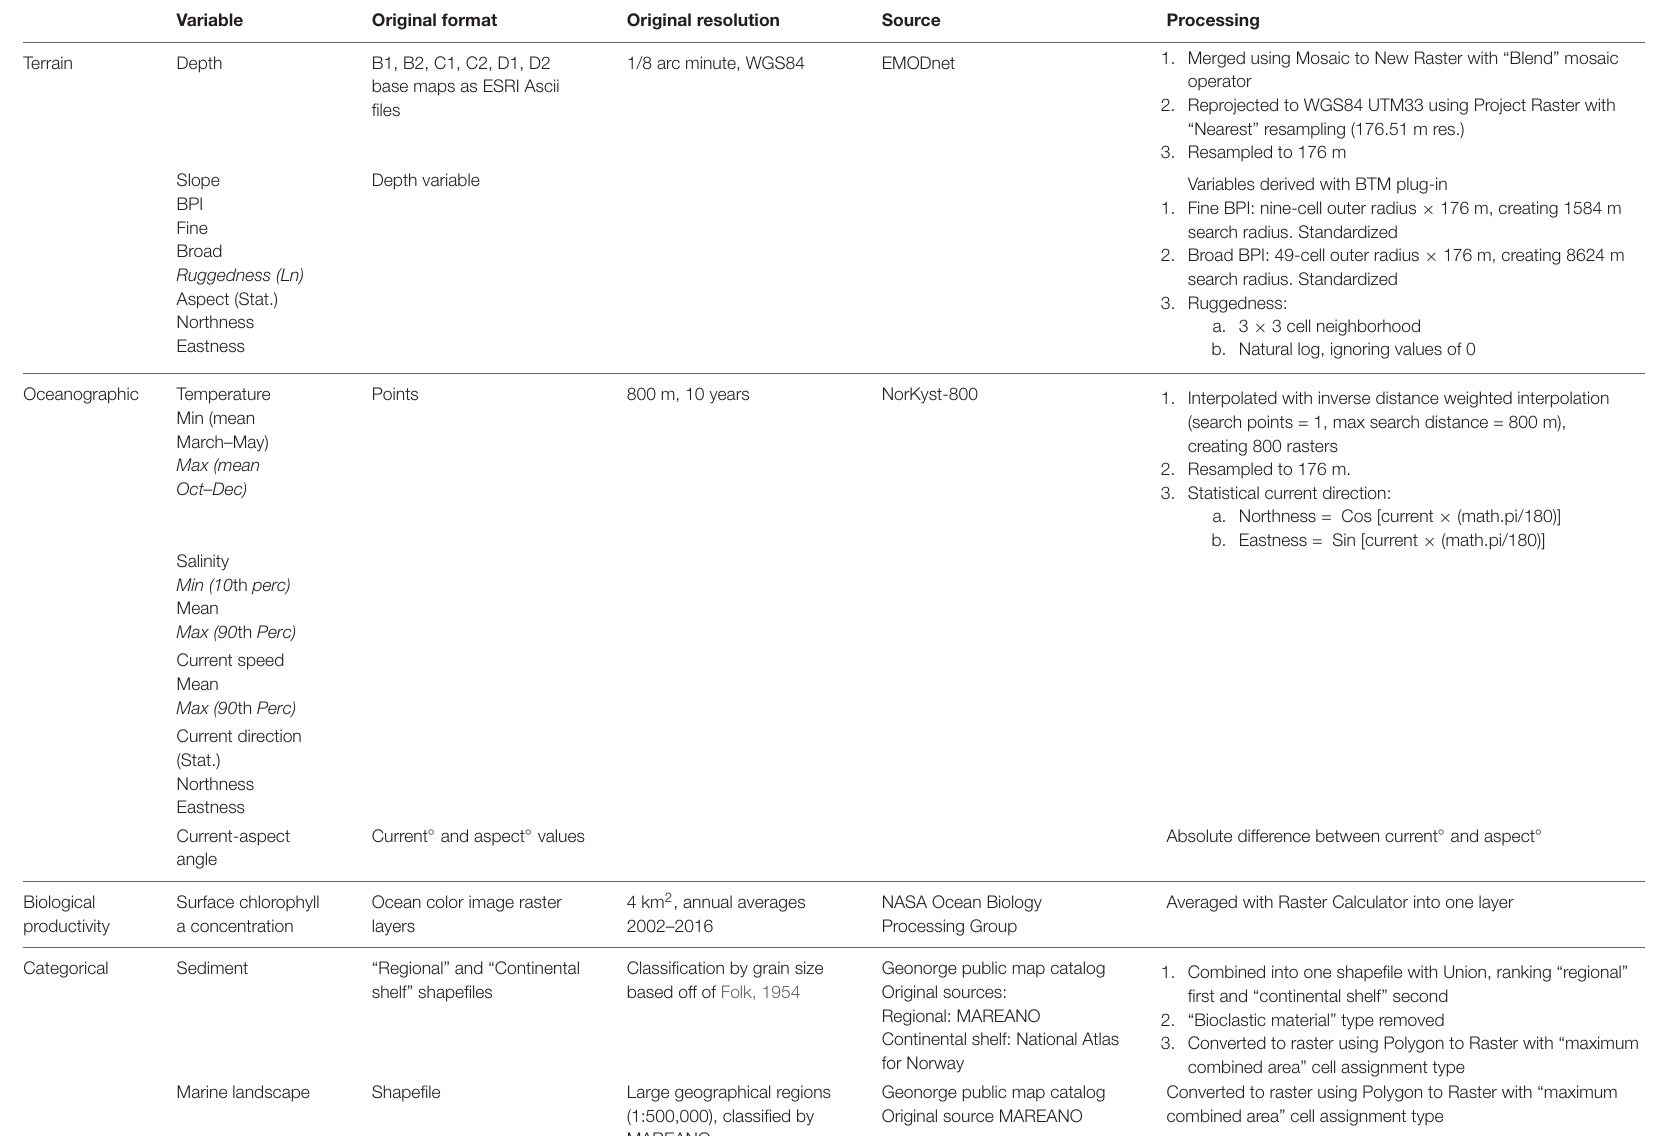
TABLE 1 | List of all obtained environmental variables, with format, resolution, sources, and processing